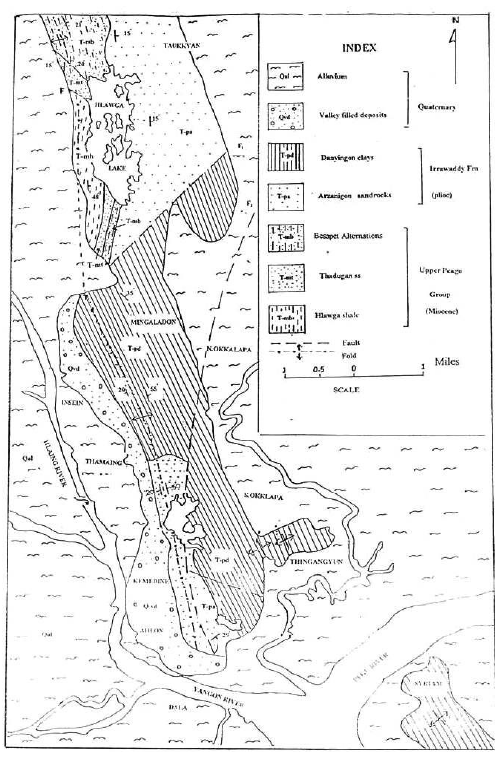
Figure 1. Soil and rock distribution of the Yangon area (Win Naing,